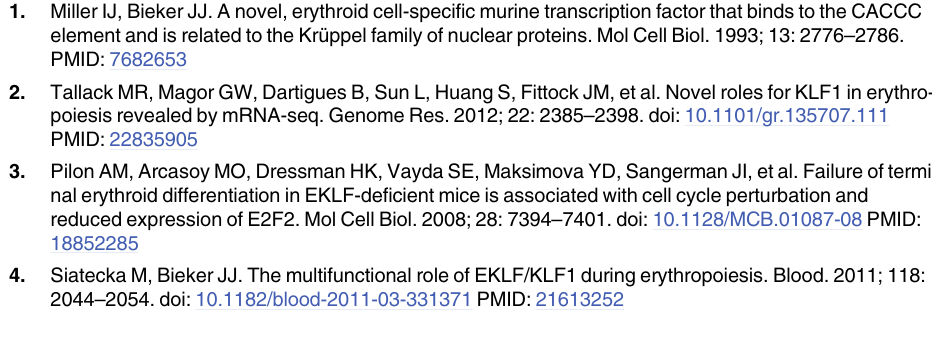
globin mRNA. S3 Fig. Role of KLF1 in KLF2 gene expression. KLF2 mRNA amount was measured in Scr and KLF1 shRNA-treated cells by qRT-PCR. The amount of KLF2 mRNA in Scr shRNA- treated cells was set to 100% for each sample. Cyclophilin A mRNA was used as the internal standard for qRT-PCR. N = 18. (A) There is no linear relationship between the amounts of KLF1 and KLF2 mRNA (r 2 = 0.13, Prob > F = 0.148). (B) Smooth curve for best fit of KLF2 mRNA with KLF1 knockdown. In most samples, KLF2 mRNA is increased with KLF1 knock- down. The curve was generated using JMP software. S1 Table. Antibodies for ChIP and Western blotting. The antibodies used for ChIP and west- ern blotting are listed, including the company from which they were purchased (source) and the catalog numbers. S2 Table. Oligonucleotide primers used for ChIP qPCR and qRT-PCR. The sequences of the oligonucleotide primers used for qPCR are listed from 5 ’ to 3 ’ . F is the forward primer and R is the reverse primer. The primers for ChIP-qPCR were used on genomic DNA templates, and the primers for qRT-PCR were used on cDNA templates. The sequences of additional qRT-PCR primers were published previously